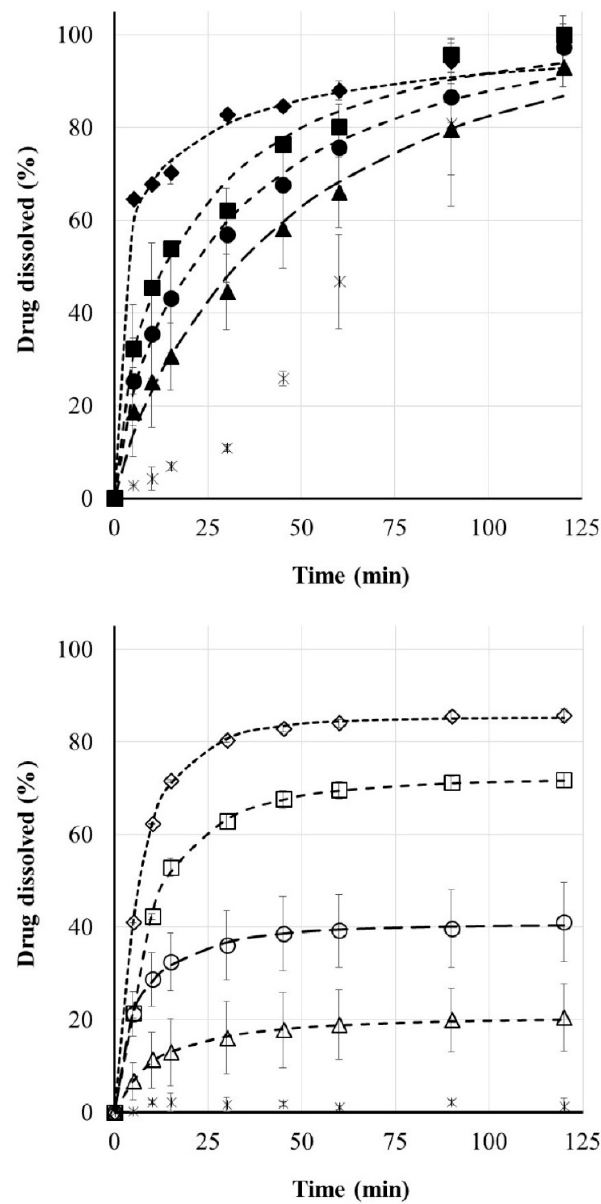
Figure 6. Drug release profile of riboflavin loaded PLA and PVA carriers printed containing various number of orifices (zero—cross; one—triangle; two—circle; three—square; four—diamond; n = 3; mean ± SD) with fitted Weibull (dotted lines).